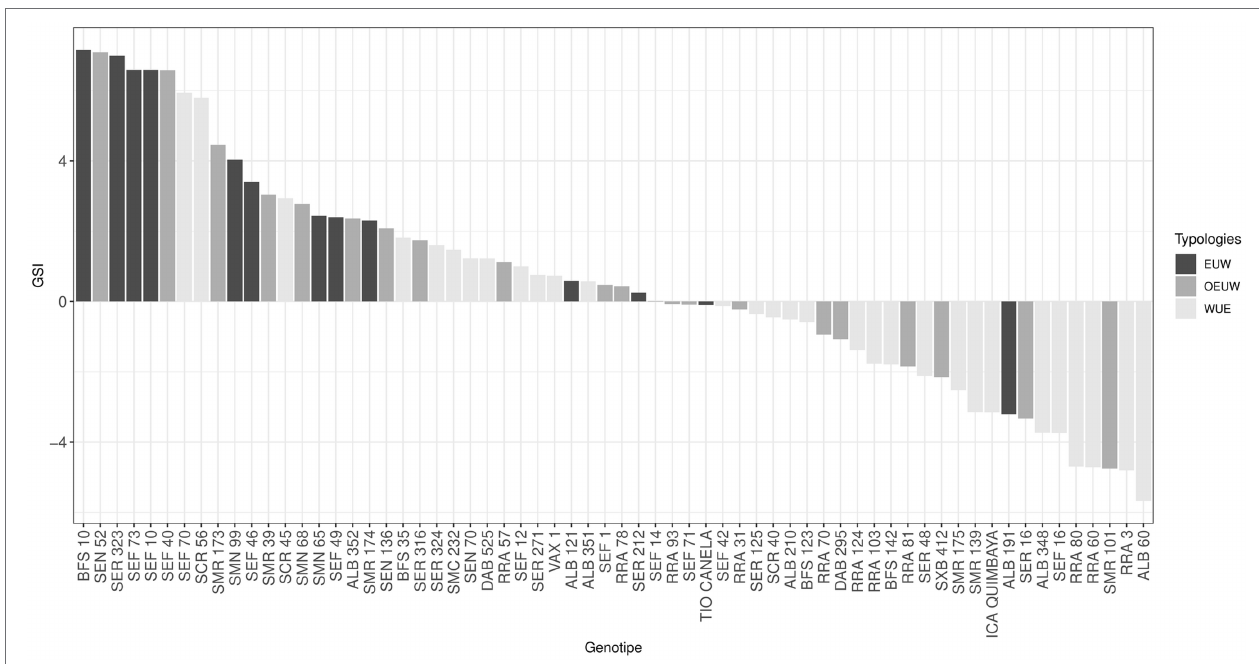
FIGURE 8 | Genotype stress index of common bean genotypes cultivated at high temperatures. EUW: Effective Use of Water, WUE: Water use efficient, OEUW: Opportunistically effective use of